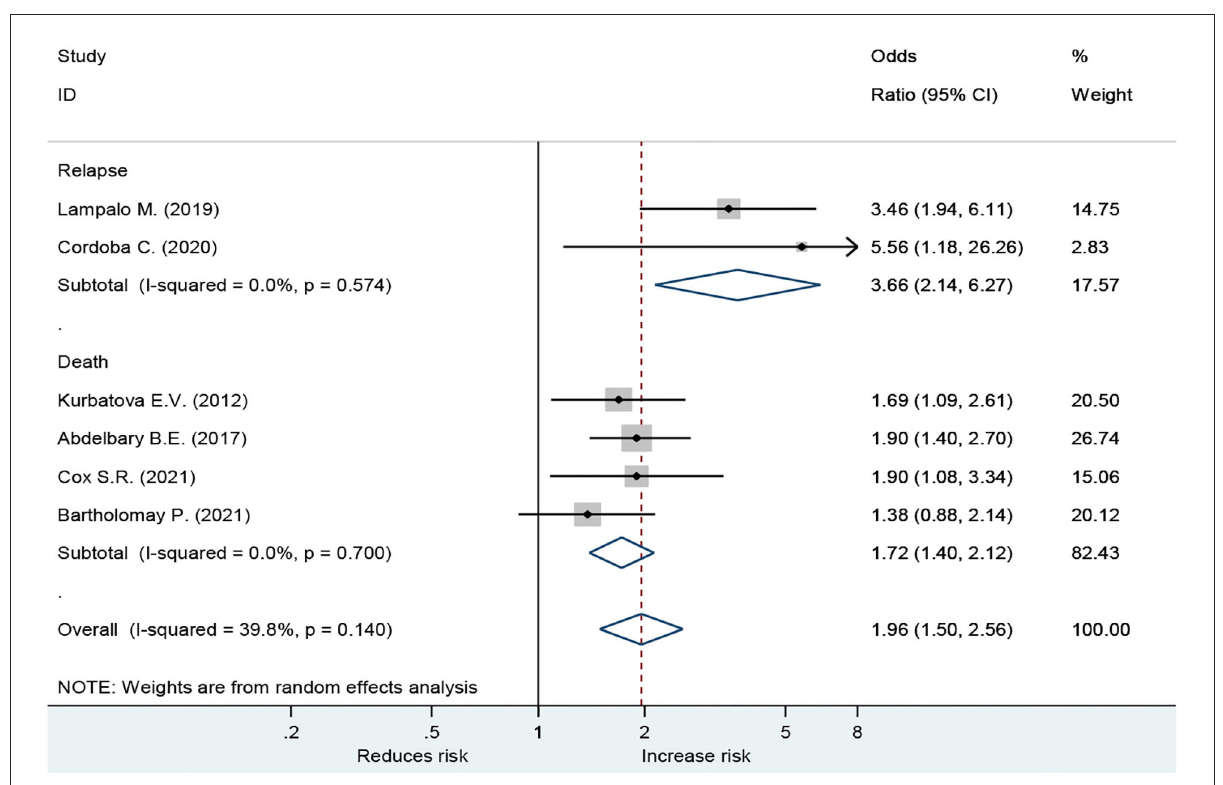
FIGURE4 Forest plot showing effect of alcohol on TB relapse in people age < 60